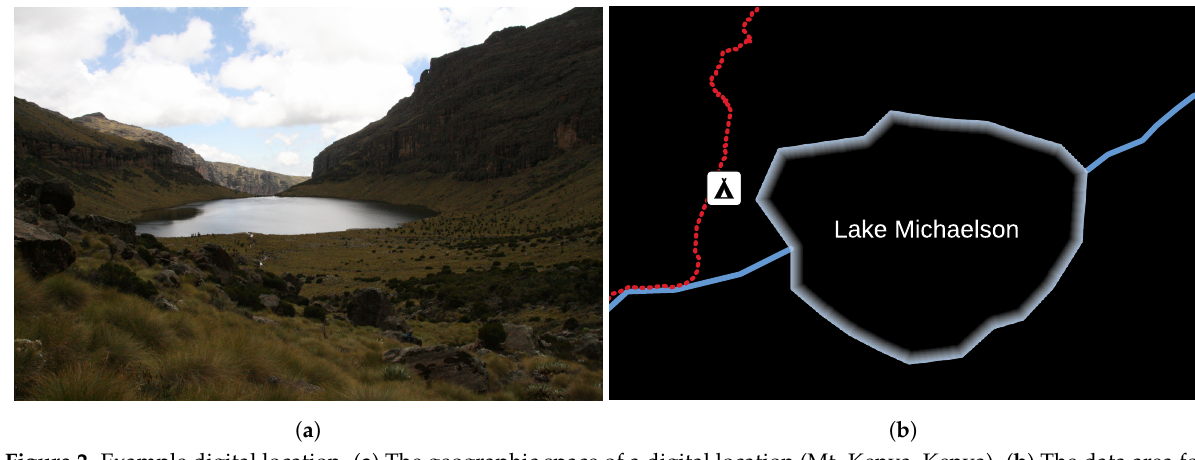
Figure 2. Example digital location. ( a ) The geographic space of a digital location (Mt. Kenya, Kenya). ( b ) The data area for the same digital location as viewed in Java OpenStreetMap Editor (JOSM). Only a small number of objects is present here in the data area with a mixture of natural and human made